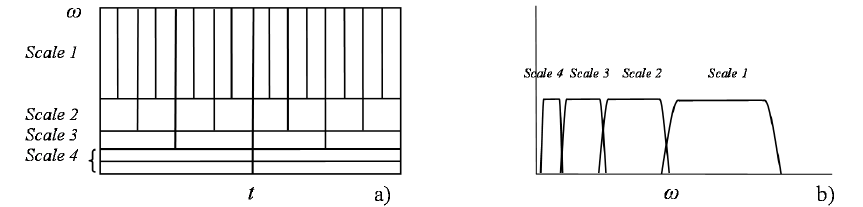
Figure 4. Schematic representation of the tiling of the time-frequency plane provided by the wavelet basis functions (“Heisenberg boxes”) ( a ), and an illustration of how wavelets divide the frequency domain ( b ), where it is possible to verify that they essentially work as a set of bandpass filters. The shape of the windows and frequency bands, for a given wavelet function, depend upon the scale index value: for low values of the scale index, the windows have good time localizations and cover a long frequency band; for high values of the scale index, the time coverage is broader and the degree of frequency localization is higher (more concentration is a narrower frequency